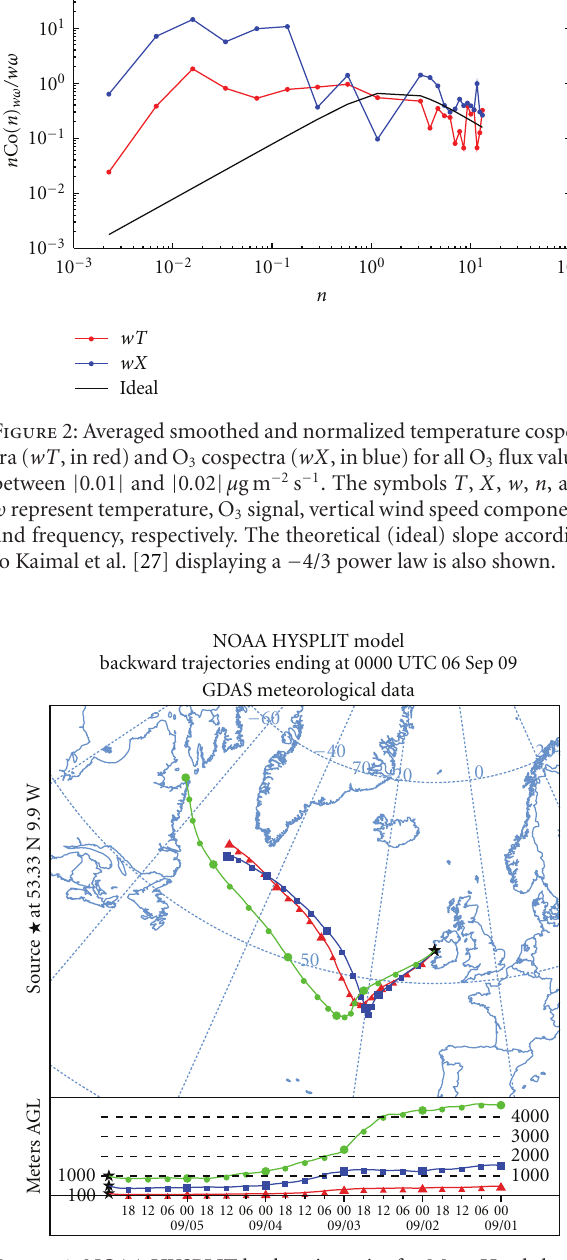
Figure 3: NOAA HYSPLIT back trajectories for Mace Head shown for period (2). These clean air sector trajectories were typical for all four periods shown in Figure 1. The red line shows 100 m, the blue line 500 m, and the green line 1000 m trajectory altitudes.